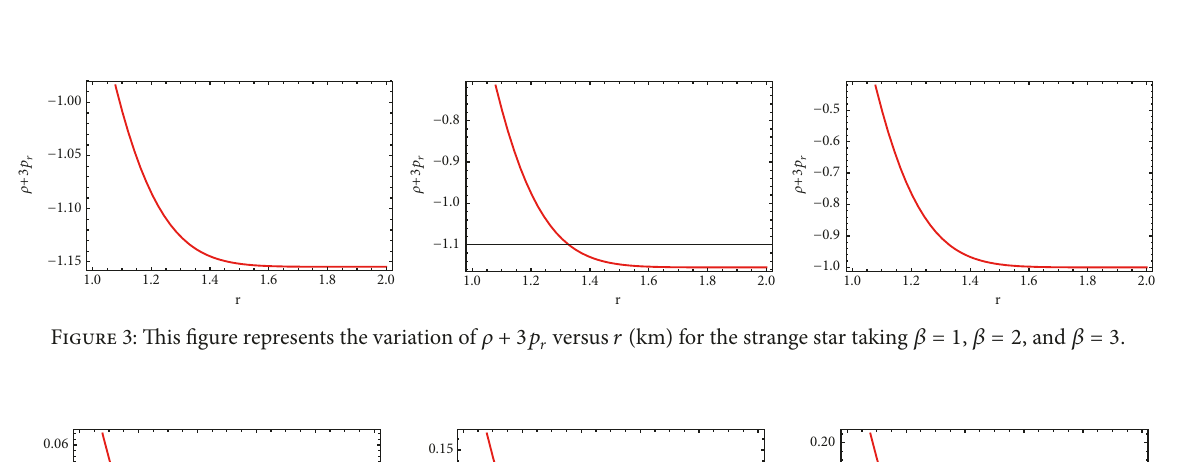
Figure 2: This figure represents the variation of 𝑝 𝑟 versus 𝑟 (km) for the strange star taking 𝛽 = 1 , 𝛽 = 2 , and 𝛽 = 3 .